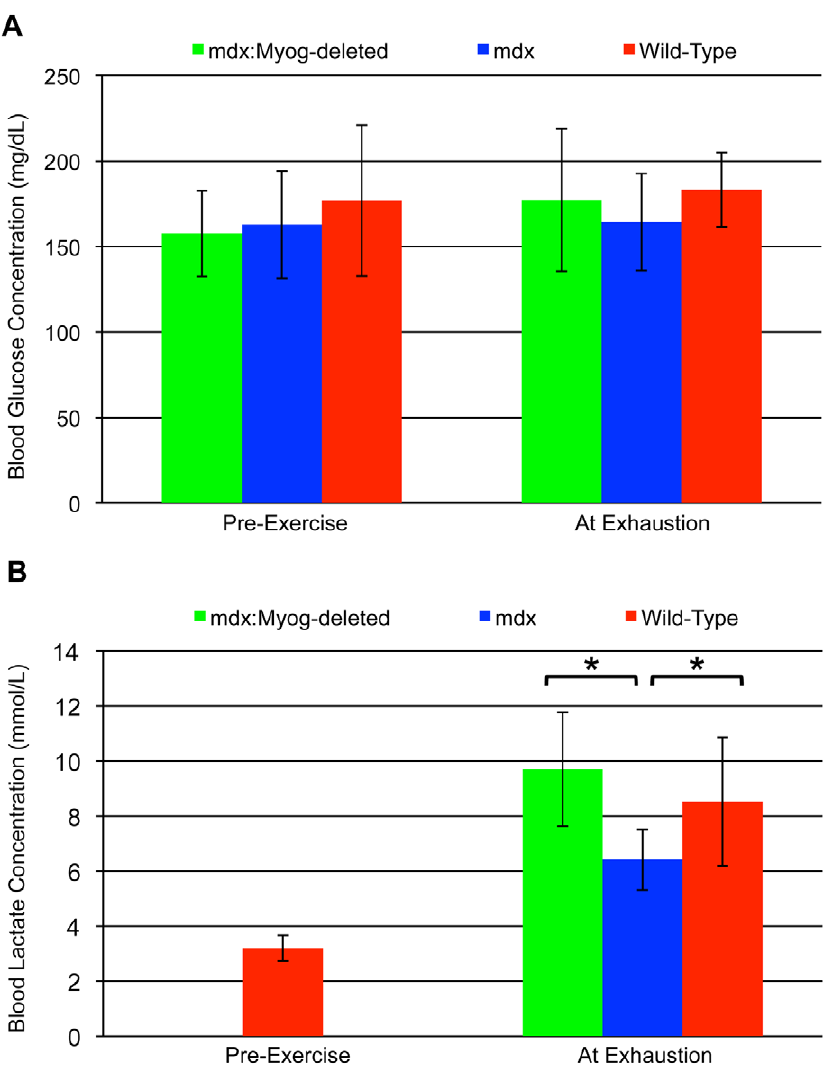
Figure 3. Normal blood glucose but increased blood lactate levels in mdx:Myog -deleted mice after high-intensity exercise. (A) Blood glucose levels in mdx , mdx:Myog -deleted, and wild-type mice (all groups, n=14) after running to exhaustion under high-intensity exercise conditions. Baseline (pre-exercise) blood glucose levels were approximately the same for the 3 test groups, ranging from 158 to 177 mg/dL. At exhaustion, blood glucose levels remained virtually unchanged for all groups. (B) Blood lactate levels were significantly elevated for the 3 test groups at exhaustion compared to wild-type pre-exercise values. Blood lactate levels at exhaustion in wild-type (n=10) and mdx:Myog -deleted (n=12) mice were significantly higher than those of mdx mice (n=11). Error bars represent 1 standard deviation (* p ,